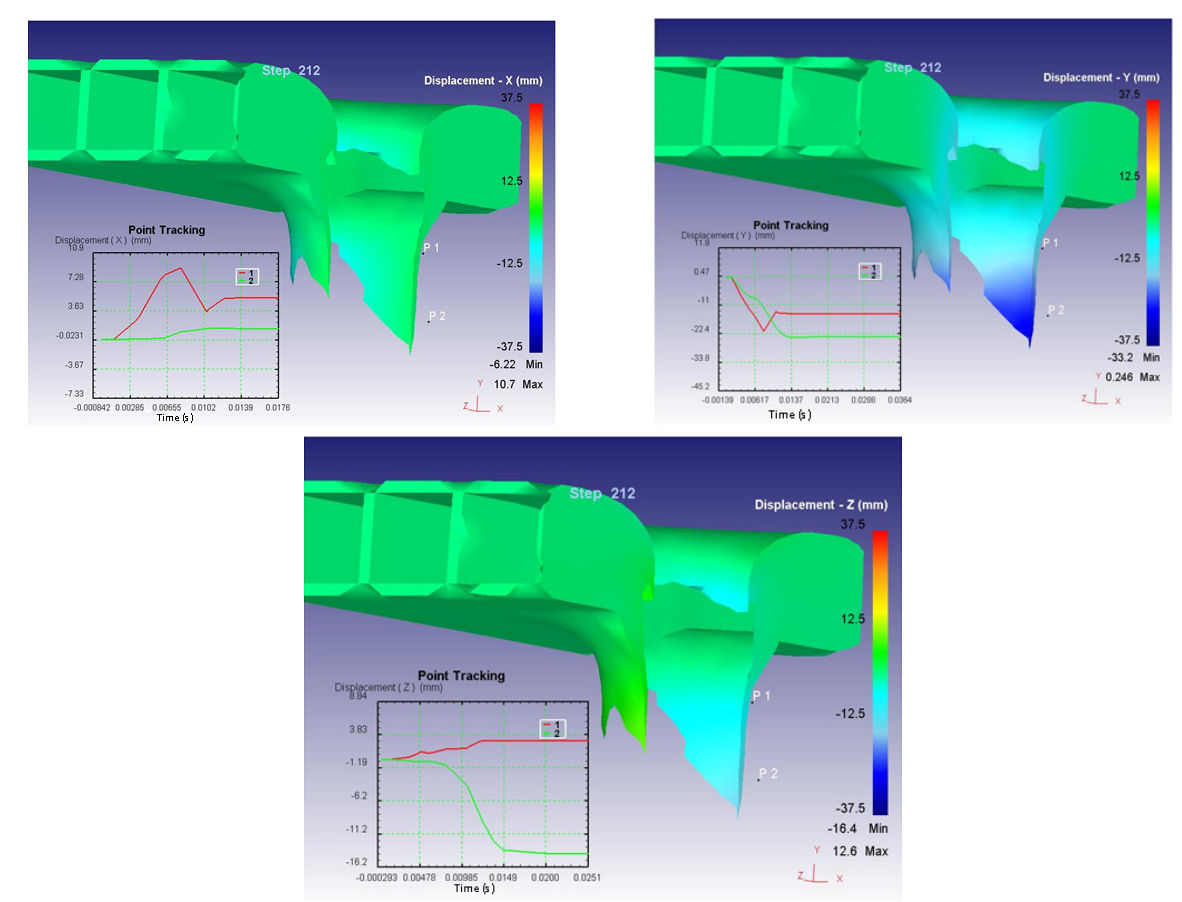
Figure 8. Variation on the 3 axes of the displacement field.